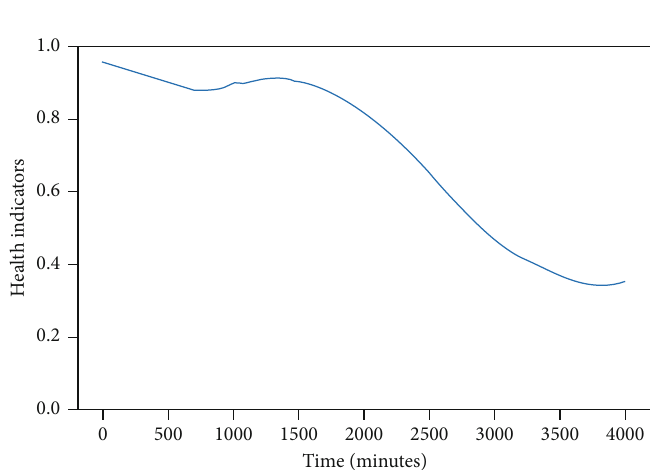
Figure 10: HI curve of pump ran